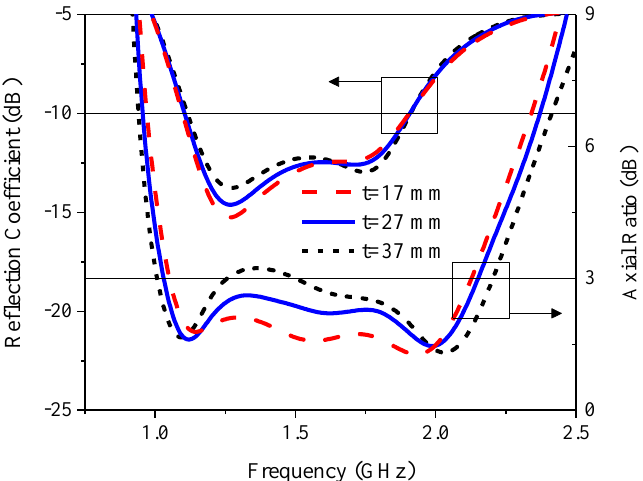
Figure 13. The simulated reflection coefficient and axial ratio under variable corner-truncated size ( t ).